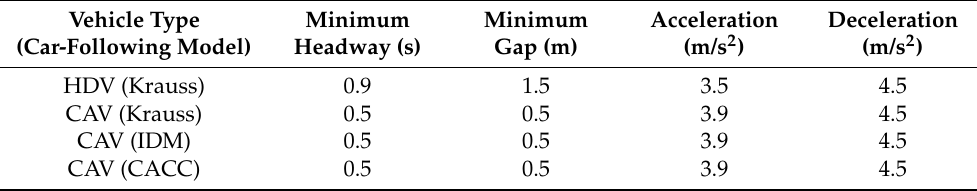
Table 2. Car-following models’